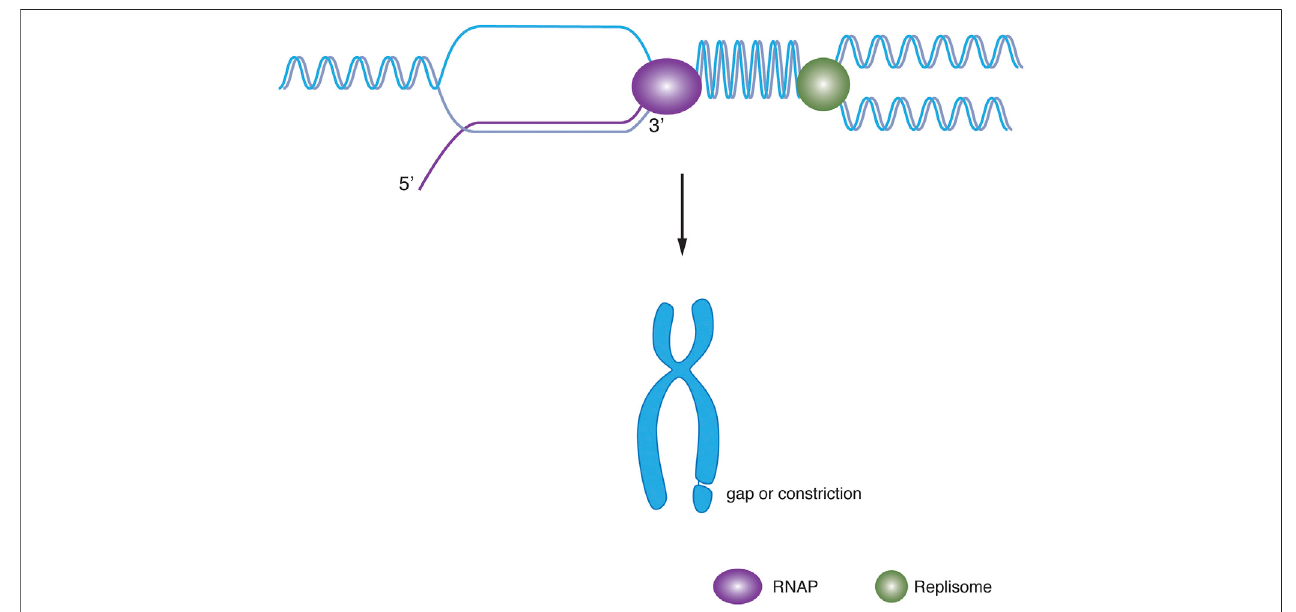
FIGURE 1 | Model for head-on collision and chromosome fragility. A head-on collision of the RNA polymerase (purple, left) with replisome (green, right) results in supercoiling and R-loop leading to chromosome fragility.